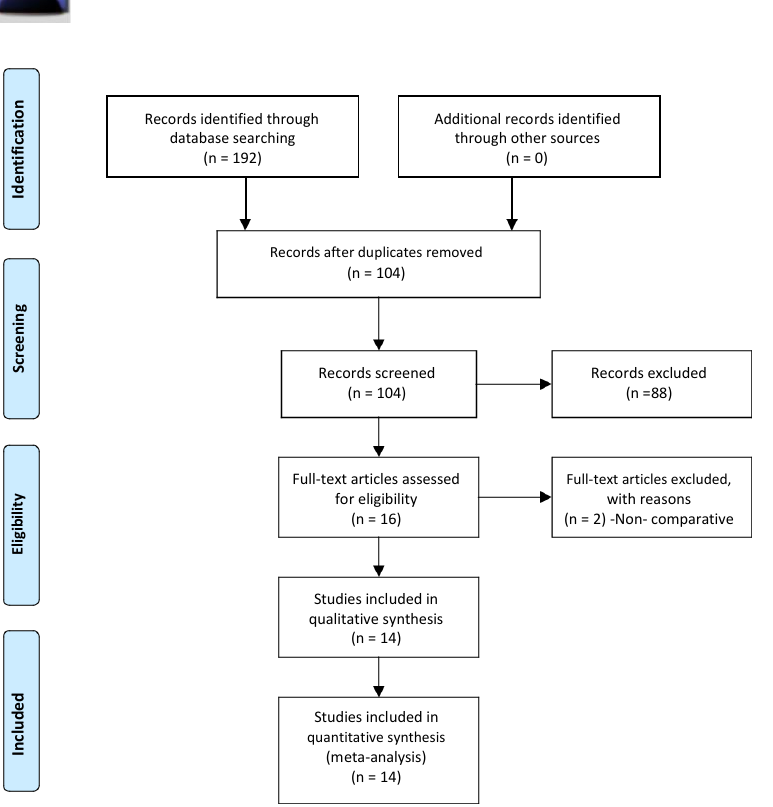
Figure 1. Selection of the relevant studies using the Preferred Reporting Items for Systematic Review and Meta-Analysis (PRISMA) flow diagram.